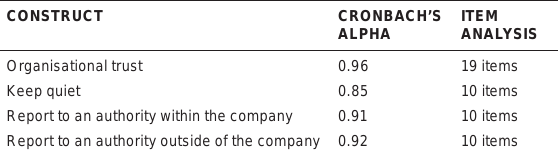
taBle 5 Reliability - results of Cronbach’s Alpha and Item